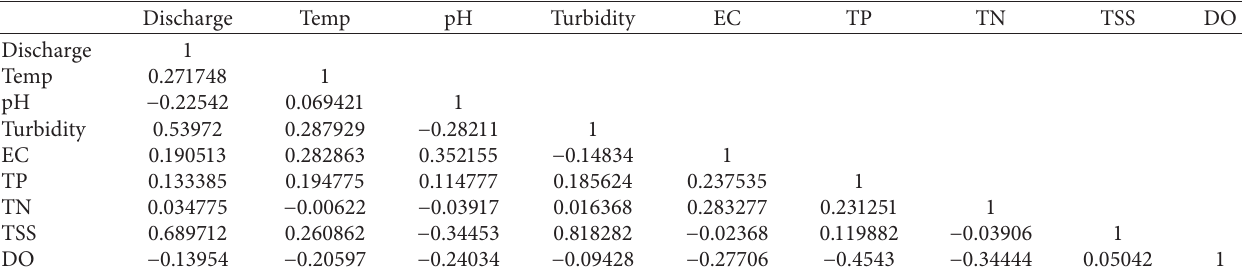
Table 2: Correlational analysis between DO and the WQ parameters.